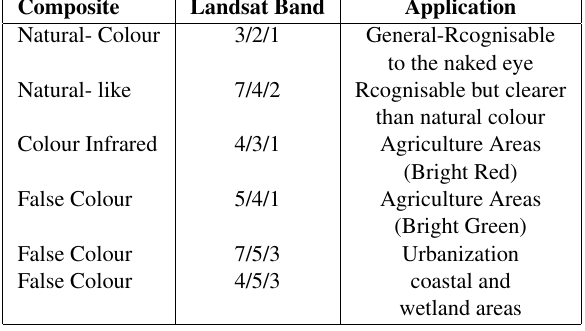
Table 1: Band Combination For Landsat Datasets